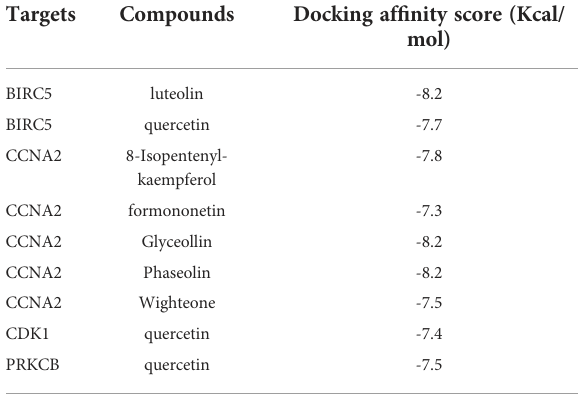
TABLE 4 Docking scores of the active ingredients of compound kushen injection with their potential targets.